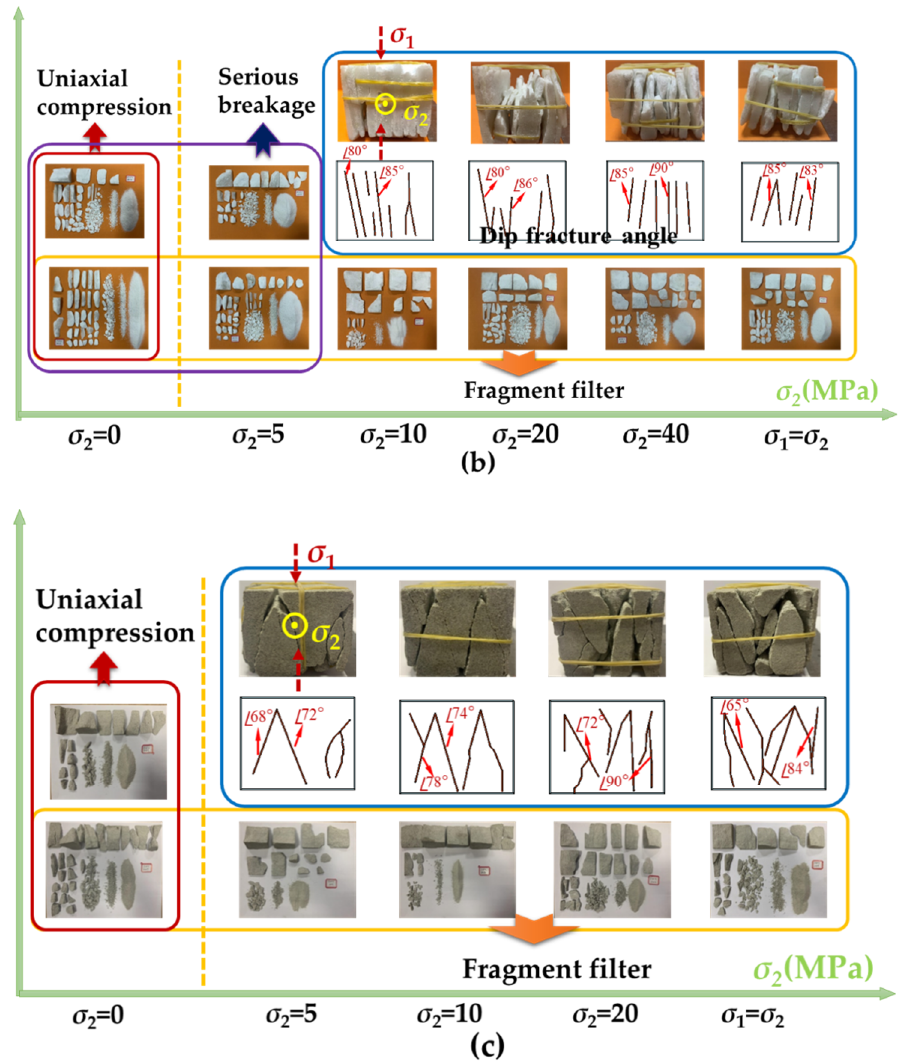
Figure 14. Fragments of ( a ) granite, ( b ) marble, and ( c ) sandstone after rock failure.